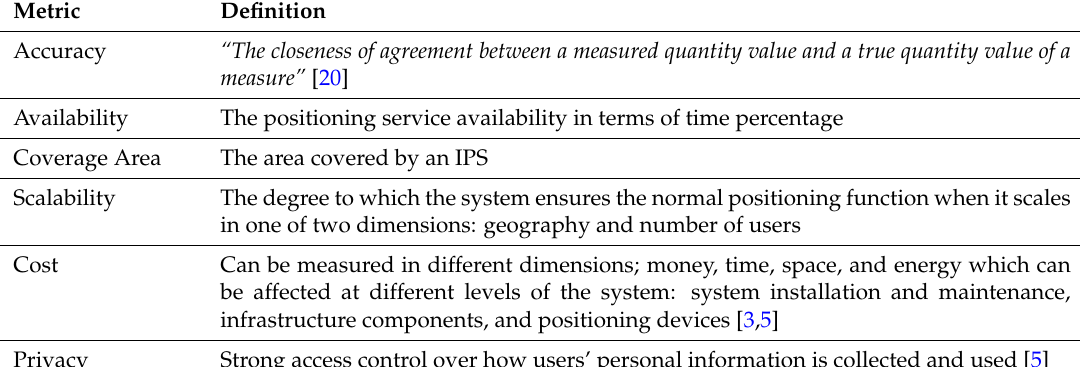
Table 3. Performance metrics of indoor positioning systems